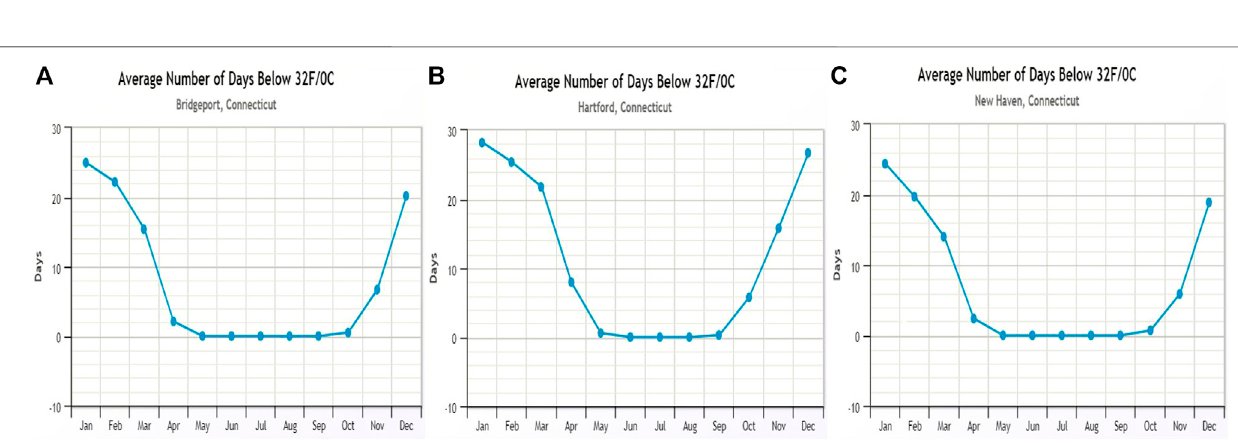
Frontiers in Built Environment |